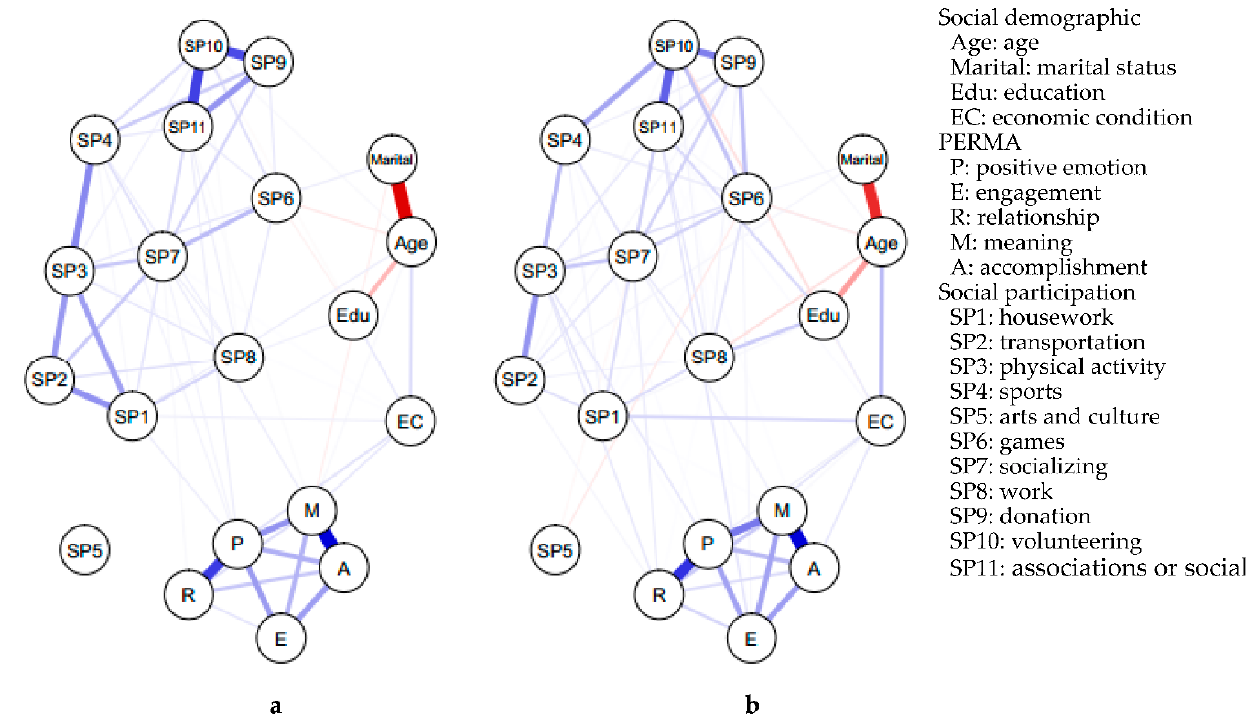
Figure 1. ( a ) Estimated network structure in male group ( n = 510). ( b ) Estimated network structure in female group ( n = 766). Circles represent variables and lines represent edges (i.e., association between two variables); the thicknesses and darkness of lines indicate the weights of the edges. Blue edges indicate positive association and red edges indicate negative association. Table 4. The weight of each connection in the network structure (males).